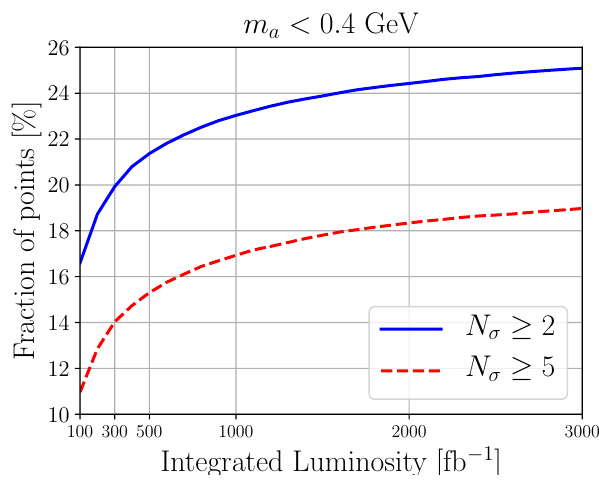
Figure 7 . The fraction of sampled points of the parameters space that have N (cid:27) (cid:21) 2 (solid line) and N (cid:27) (cid:21) 5 (dashed line) at the 13 TeV LHC in the monophoton channel as a function of the integrated